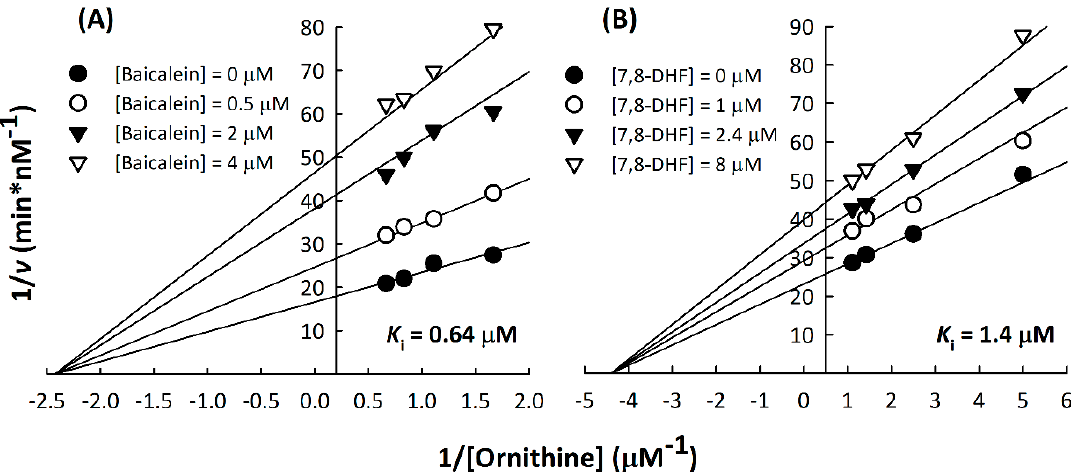
Figure 3. Non-competitive inhibition of human ODC by baicalein or 7,8-DHF. Double reciprocal plots for the inhibition of ODC with ( A ) baicalein and ( B ) 7,8-DHF with respect to the ODC substrate ornithine. Human ODC activity was measured using different concentrations of ornithine with various concentrations of baicalein (0, 0.5, 2, and 4 µM) or 7,8-DHF (0, 1, 2.4, and 8 µM).